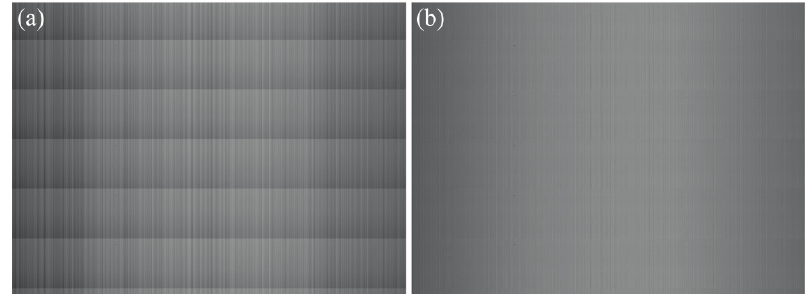
Figure 13. Comparison of visual effect of a uniform-light image. ( a ) Original image; ( b ) Corrected image.